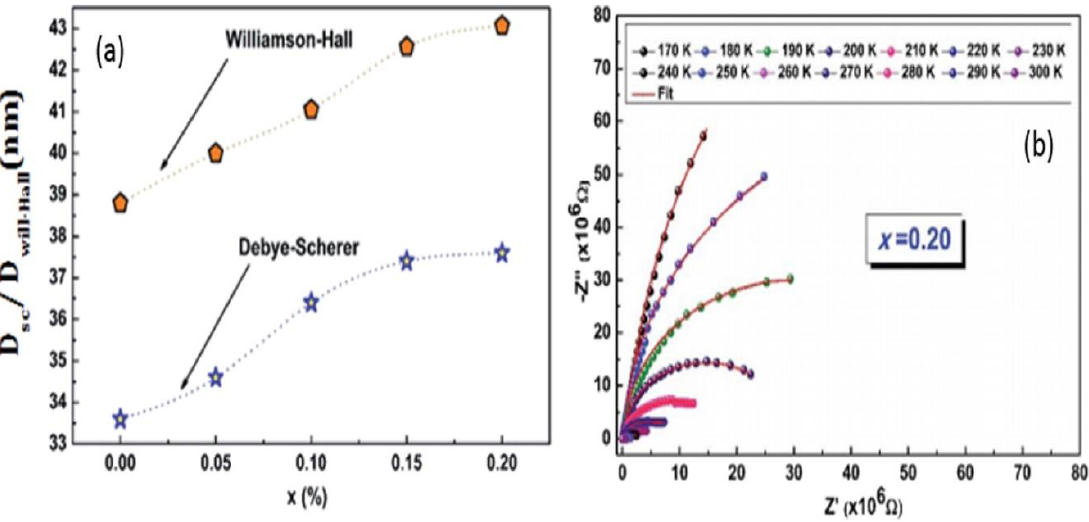
Figure 5. ( a ) Average crystallite size from the Debye-scherer and Willianson-Hall methods for [(La 0.8 Ca 0.2 )] 1x Bi x FeO 3 ( b ) The Nyquist diagram for [(La 0.8 Ca 0.2 )] 1x Bi x FeO 3 [27].